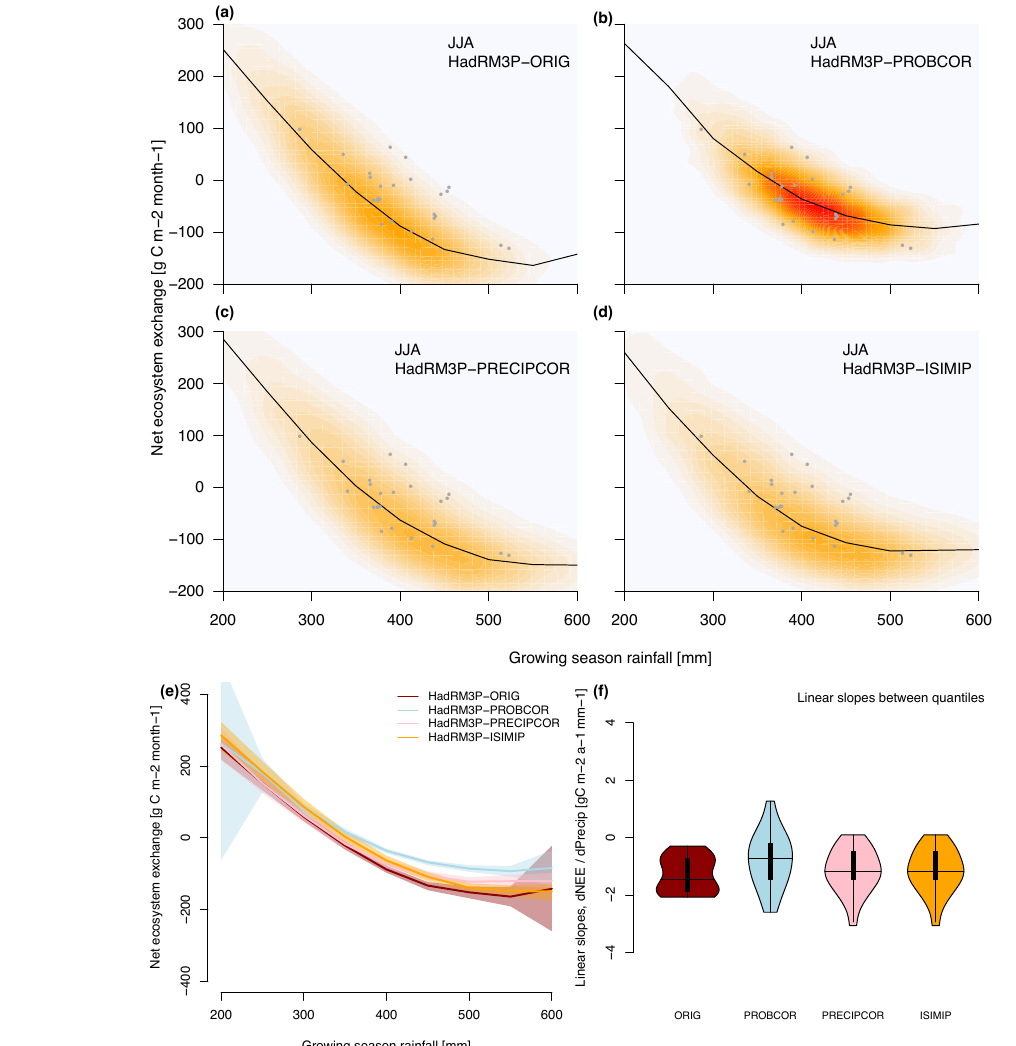
Figure 7. (a–d) Kernel density plots of the sensitivity of simulated annual NEE to growing season rainfall in LPJmL under four different bias correction schemes. Grey dots denote ERA-Interim control simulations in each plot, black lines indicate piecewise linear regressions. (e) Piecewise linear regression relations for each bias correction scheme. Shaded colours indicate confidence intervals (5–95th percentile of piecewise linear regression derived by bootstrapping). (f) Distribution of linear regression slopes (dNEE / dRainfall) between regularly spaced quantiles of the rainfall distribution for each bias correction scheme, shown as violin